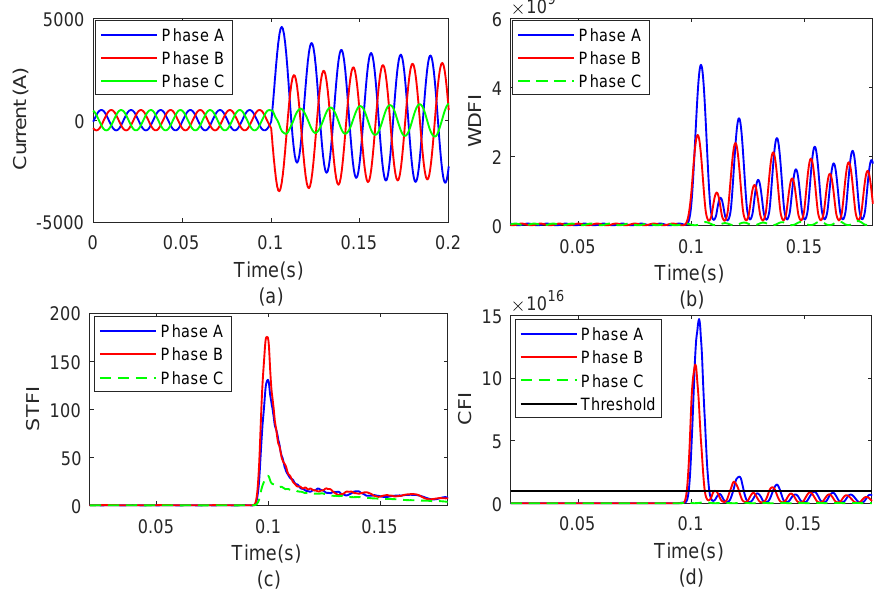
Figure 7. Detection of fault incident between phases A and B to ground ( a ) current waveform ( b ) WDFI ( c ) STFI ( d )